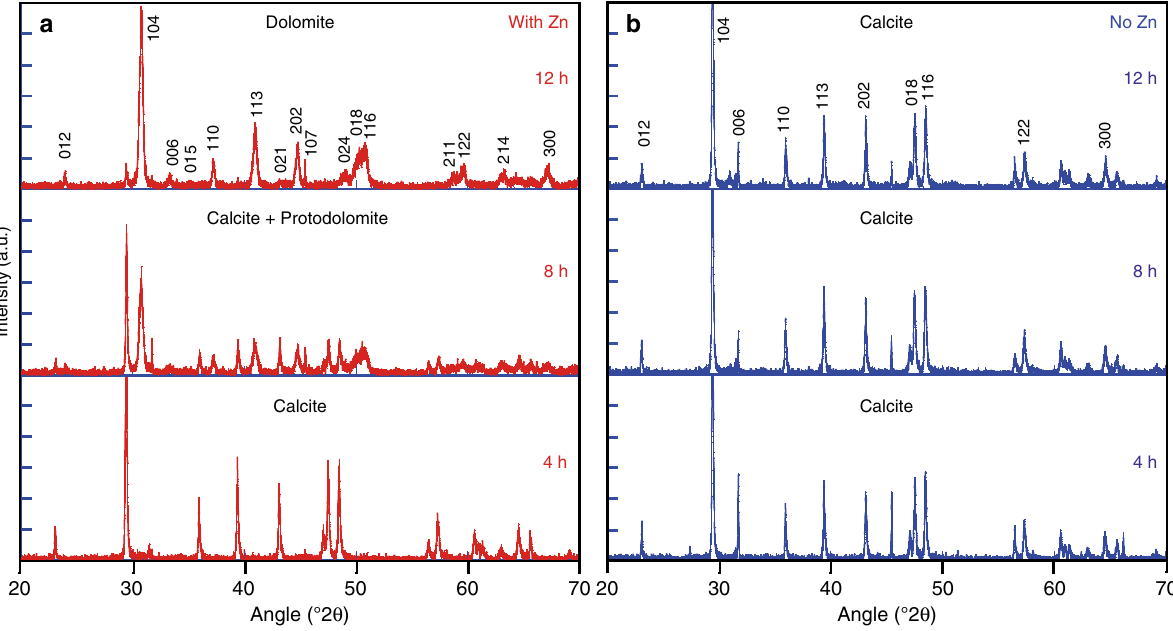
Fig. 1 Powder X-ray diffractograms (selected 20 – 70 °2 θ ) of reaction products in the main experiment series at selected time intervals of 4, 8, and 12 h. The dolomite and calcite characteristic re fl ections are indicated in a and b , respectively. The peak at 31.7 °2 θ in some diffractograms is due to minor halite that was not entirely dissolved during the rinsing process of the product or developed during drying of the